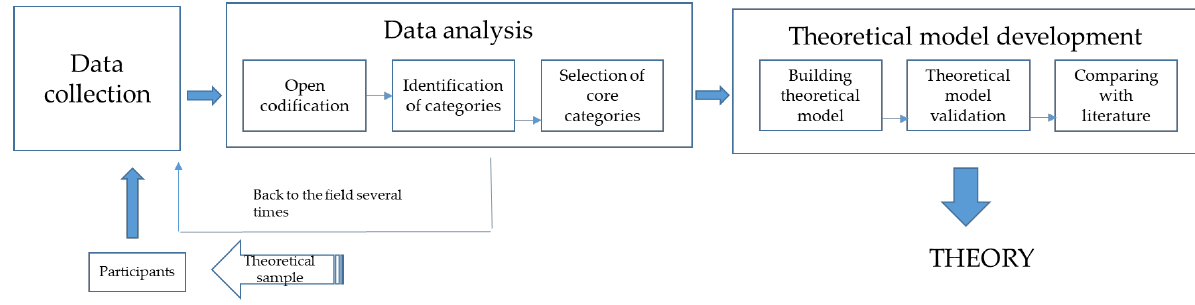
Figure 1. Research Process. Source: Adapted from Strauss and Corbin